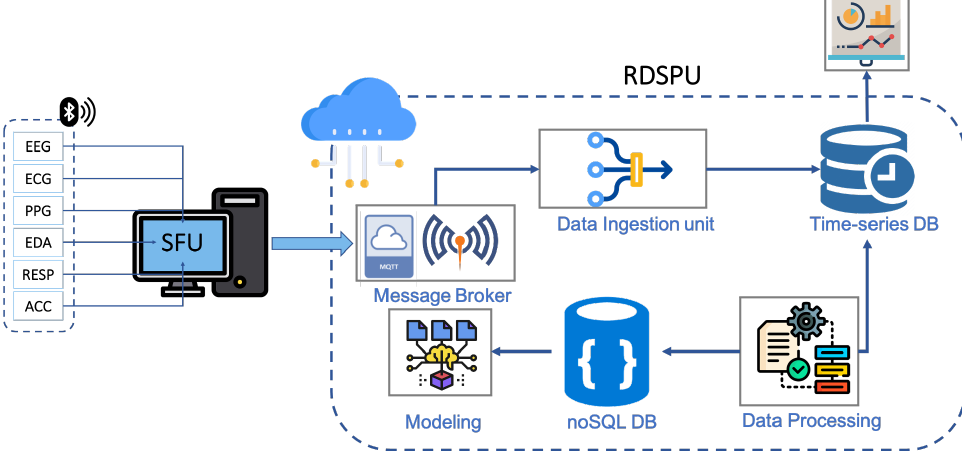
Figure 1. Summary of the WMP architecture. On the left side: The sensor fusion unit (SFU). On the right side: The remote data storage and processing unit